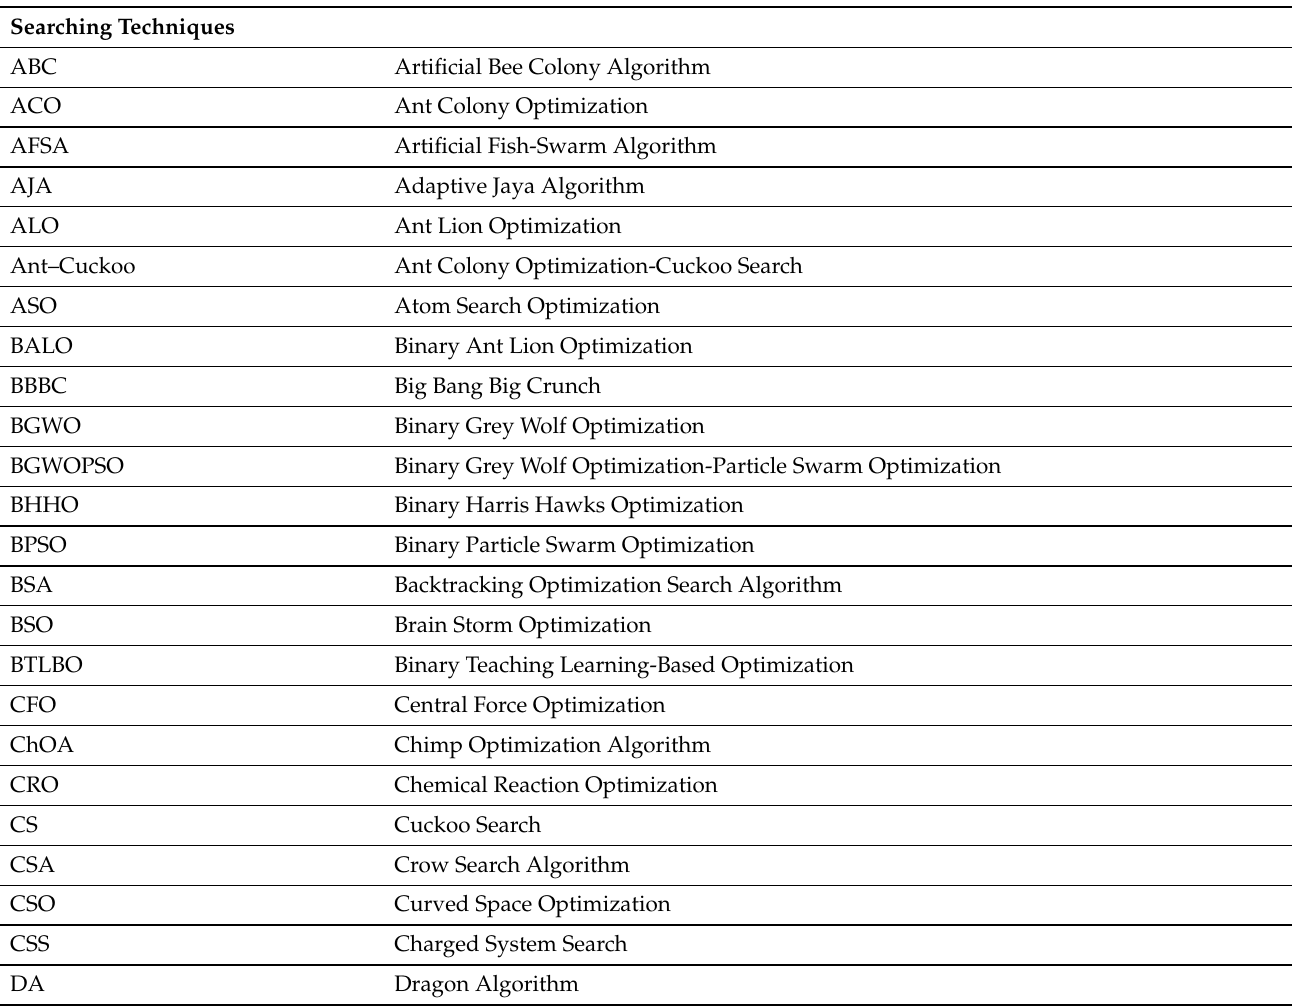
Table 1. Acronyms of the reviewed FS methods and respective evaluation